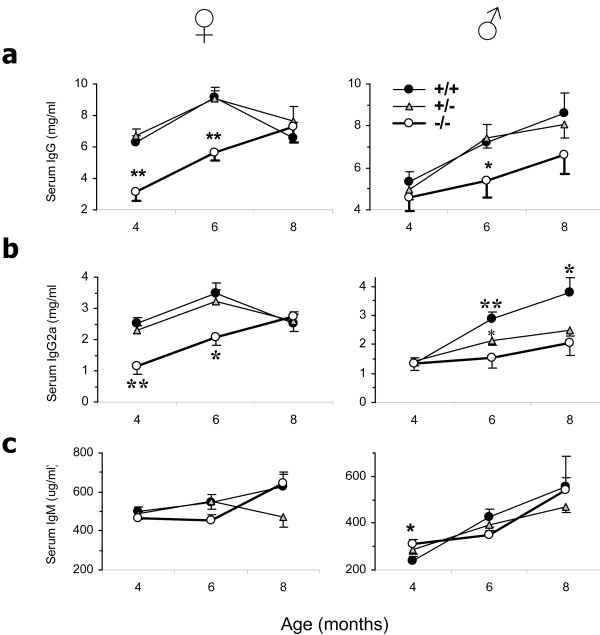
Serum immunoglobulin (Ig) levels in β2 microgloblin-deficient (β2m°) BWF1 mice: reduced polyclonal total IgG, but not IgM. β2m+/+ (n = 18 to 22 female and 12 male, closed circles), β2m+/- (n = 30 to 35 female and 28 to 35 male, triangles) and β2m° (n = 11 to 16 female and 10 to 16 male, open circles) mice were bled and sera tested for total IgG, IgG2a and IgM. Results are expressed as the mean ± standard error. (a, b) Serum levels of total IgG and IgG2a isotype were lower in β2m° mice than in control animals (*P <0.05, **P <0.01 to <0.001; Student's t-test). (c) Serum levels of total IgM were higher in β2m° than in β2m+/+ mice (*P <0.05, Student's t-test).